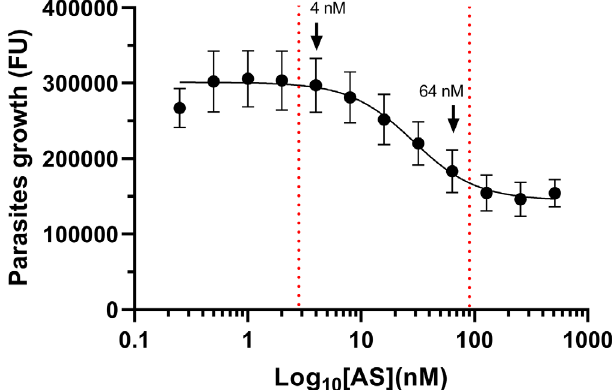
Figure 1. Parasite growth inhibition curve with artesunate concen- tration for the quantitative test. This curve resulted from the analysis of data sets from nine independent assays using a four-parameter nonlinear regression. Each concentration was tested in triplicate in each independent assay. The X -axis was transformed into logarithm to the base 10 to better visualize the linear portion of the curve. Data are presented as the mean ± SD ( n (cid:5) 9). FU = fl uorescence unit; Log 10 = logarithm to the base 10; [AS] = artesunate concentration; nM = nanomolar; Red-dotted lines = indicate linearity